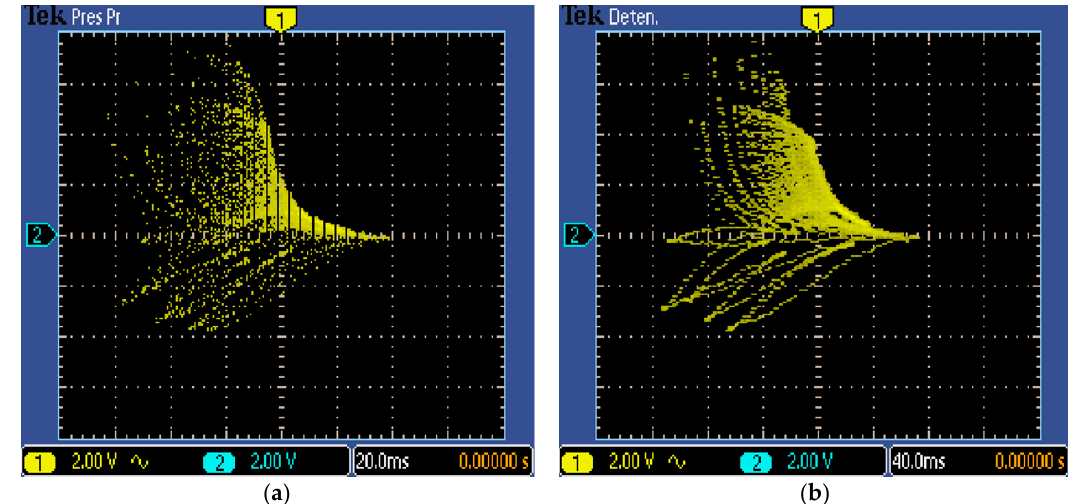
Figure 10. Oscilloscope views in the x - y plane (2v/div) of the new chaotic System (2) implemented in field-programmable gate array (FPGA) and with: ( a ) Forward-Euler with h = 0.001 and ( b ) fourth-order Runge-Kutta with h = 0.01.